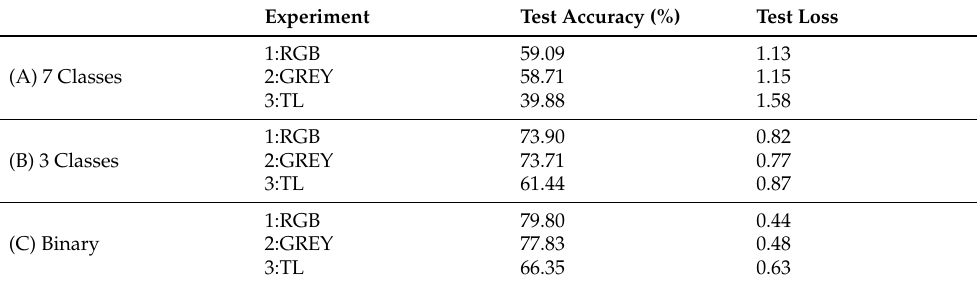
Table 10. Testing Accuracy and Loss Values (All Models).